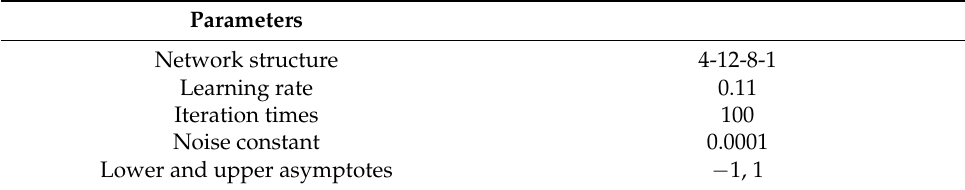
Table 6. Experimental parameters of the continuous deep belief